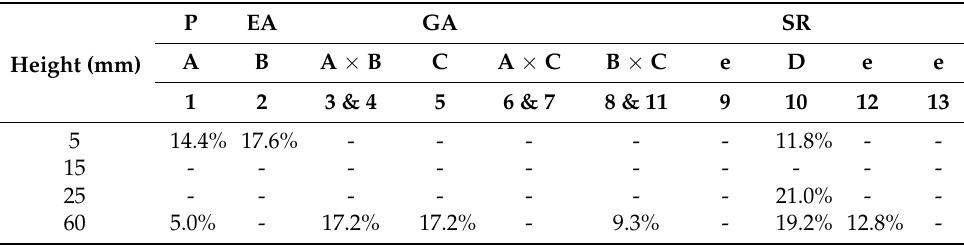
Table 10. The overall influences of the parameters on fuel bed temperature.